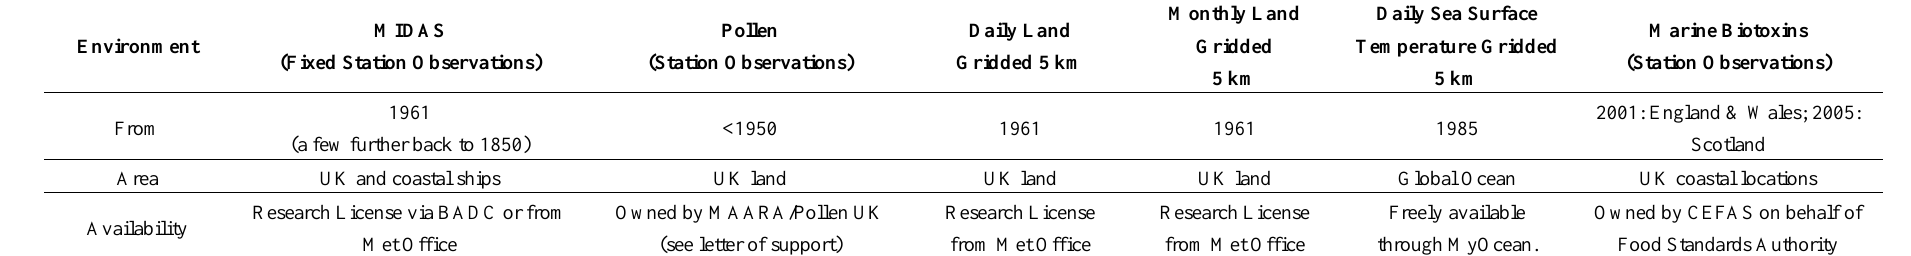
Table 5. Summary table of environmental databases the MED MI Partnership has identified, as well as other databases for potential future collaborations (more details at